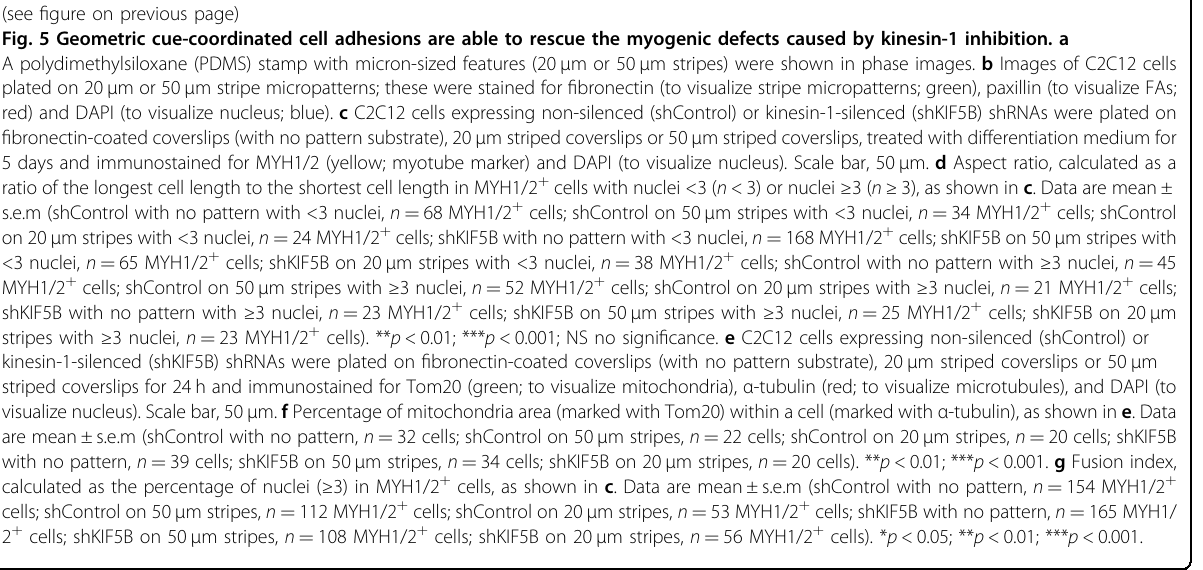
treatment (Fig. 4f). By plating C2C12 cells onto fi bronectin-coated microstripes, and thereby forcing integrin β 1 activation in cells with polarized morphology, the defects caused by kinesin-1 disruption in mitochon- dria distribution (Fig. 5e, f) and myogenic differentiation (Fig. 5g) can be rescued. This new fi nding indicates that integrin β 1 activation plays a crucial role in driving the myogenic machinery, and that this is regulated by microtubule motors kinesin-1.